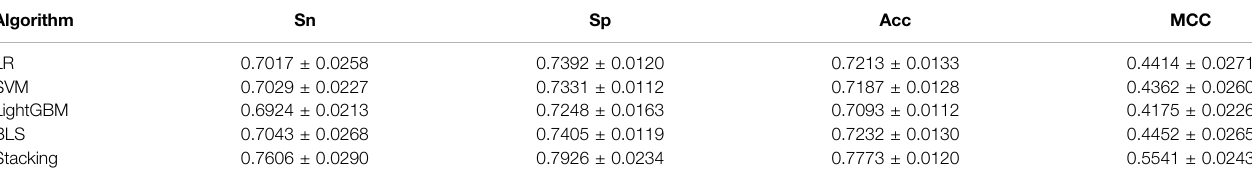
TABLE 5 | Performance comparison of different classi fi cation algorithms on the training set according to ten-fold cross-validation. Algorithm